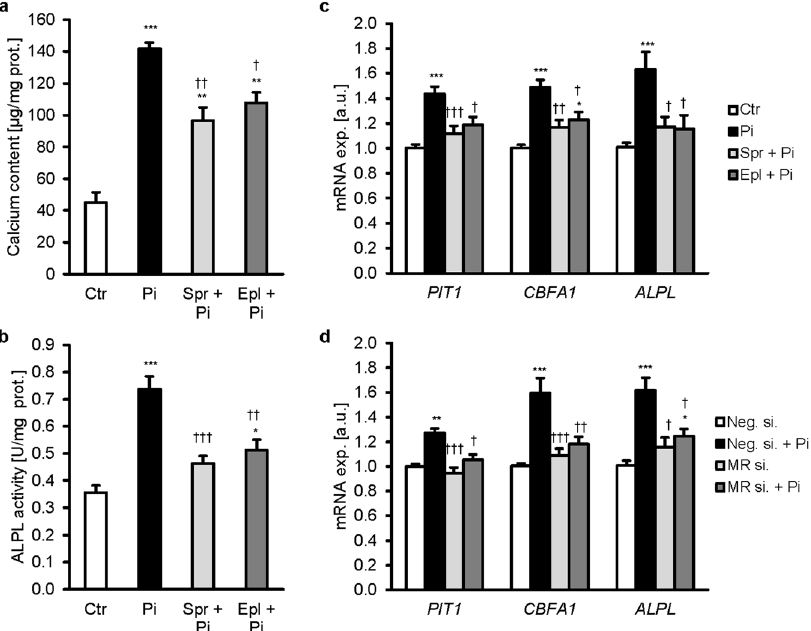
Figure 1. Mineralocorticoid receptor blockade ameliorates phosphate-induced calcification in vitro . Arithmetic means ± SEM of calcium content ( a , n = 3; µ g/mg protein), alkaline phosphatase activity ( b , n = 6; units/mg protein) and of PIT1 , CBFA1 and ALPL relative mRNA expression ( c , n = 14; arbitrary units, a.u.) in HAoSMCs following treatment with (Pi) or without (Ctr) phosphate and with or without additional treatment with 10 µ M spironolactone (Spr) or 10 µ M eplerenone (Epl). ( d ) Arithmetic means ± SEM of PIT1 , CBFA1 and ALPL relative mRNA expression (n = 10; a.u.) in HAoSMCs following silencing for 48 hours with negative control siRNA (Neg.si.) or MR siRNA (MRsi.) without or with treatment for 24 hours with phosphate (Pi). * (p < 0.05), ** (p < 0.01), *** (p < 0.001) statistically significant vs control treated or Neg.si. silenced HAoSMCs, respectively. † (p < 0.05), †† (p < 0.01), ††† (p < 0.001) statistically significant vs Pi treated or Neg.si. silenced and Pi treated HAoSMCs,